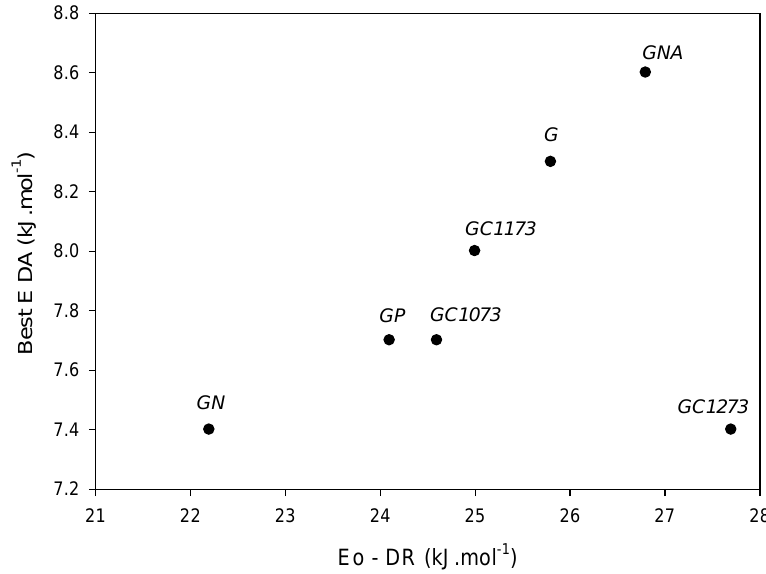
Figure 2. The relationship between the Eo parameters of the equation of DR and E of the equation of DA.